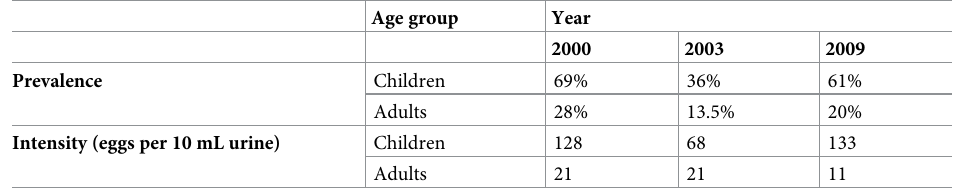
Table 4. Kenyan community study of MDA for S . haematobium control. Table shows prevalence and intensity of S